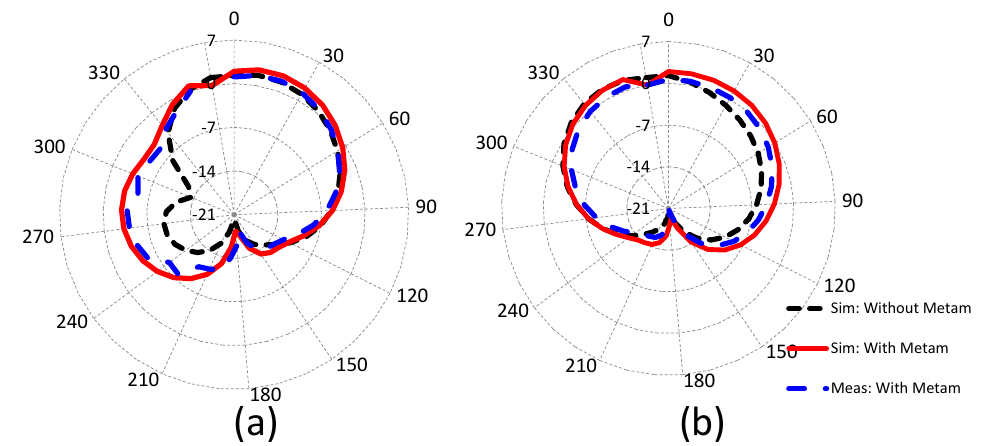
Figure 8. Measured and simulated radiation pattern(with and without metamaterial) at 5.8 GHz ( a ) Phi = 0 0 ; ( b ) Phi = 90 0 .